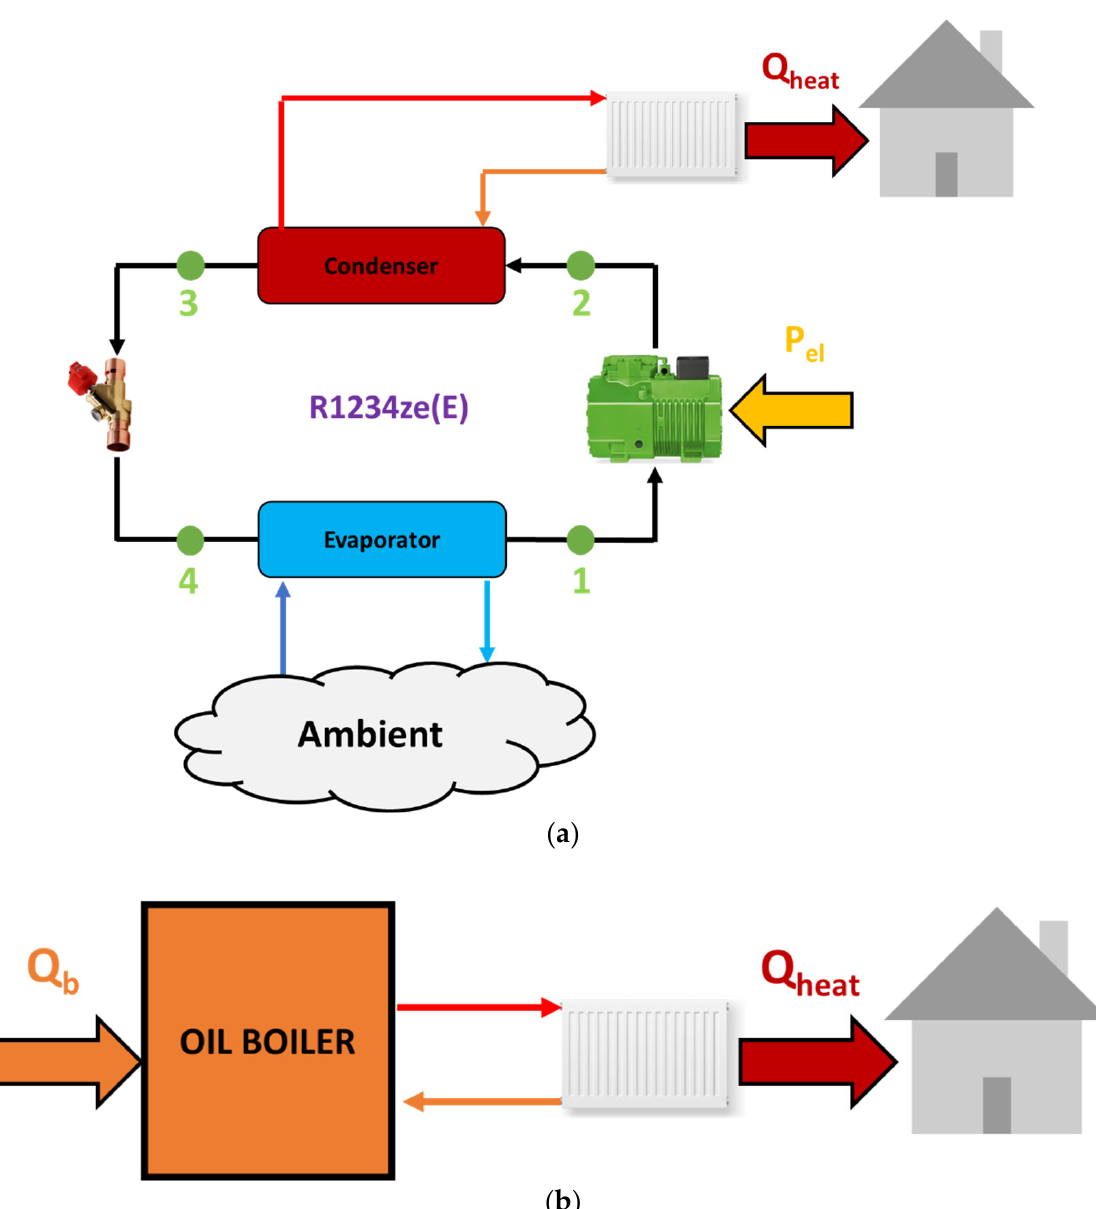
Figure 1. The examined heating systems: ( a ) system with high-temperature heat pump, and ( b ) systems with oil boiler.